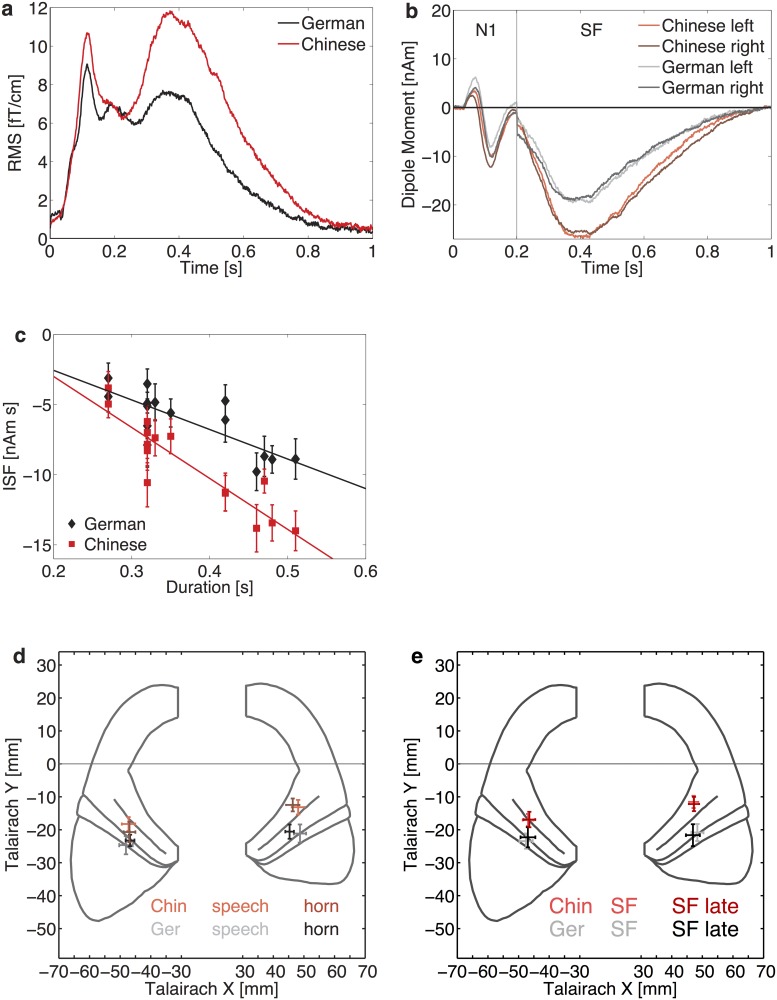
Grand-mean waveforms.(a) Grand-mean RMS of all pooled phonetic responses used in experiment 1, for Chinese (red) and German (black) listeners. (b) Grand-average source waveforms of all pooled phonetic responses of the N100m and the SF with one equivalent dipole in each hemisphere. Waveforms shown in the time interval from 0–200 ms were based on a fit of the transient N100m. The waveforms shown in the second part of the plot (200–1000 ms) were derived from a dipole model of the SF which was based on a fit interval from 300–600 ms after tone onset. Note the similarity of data derived from the left and right hemisphere. (c) Integrated sustained field (ISF) plotted against stimulus duration. The error bars depict the standard error of the mean. (d) Projection of the mean Talairach coordinates of the dipole models of both groups for the speech sounds and the horn tone onto the map of Schneider et al. [40]. The error bars represent the standard errors of the mean along the x- and y-axis. (e) Mean Talairach coordinates of the ISF-generators for speech signals, derived from the standard fit interval (300–600 ms after tone onset) of the Chinese (red) and German (grey) listeners and the corresponding positions based on the late fit interval (500–800 ms, Chinese (dark red) and German listeners (black)).